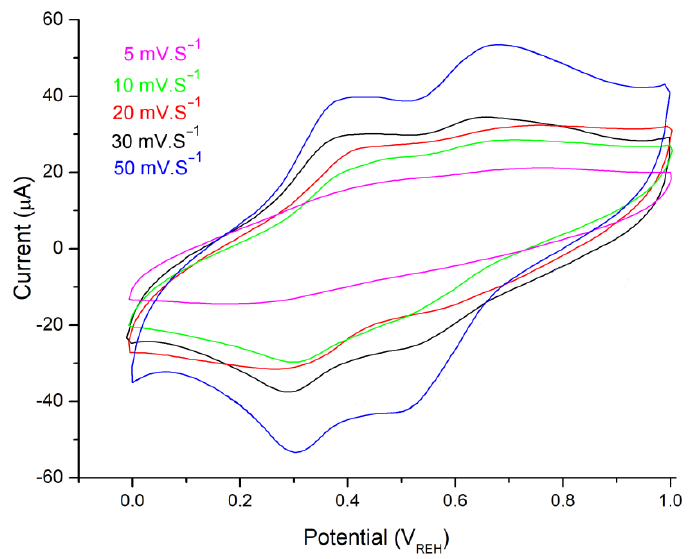
Figure 9. CV profiles of the PANI@TiO 2 –CuO electrode at various sweep rates at 1.0 A g − 1 in HCl solution (1M).